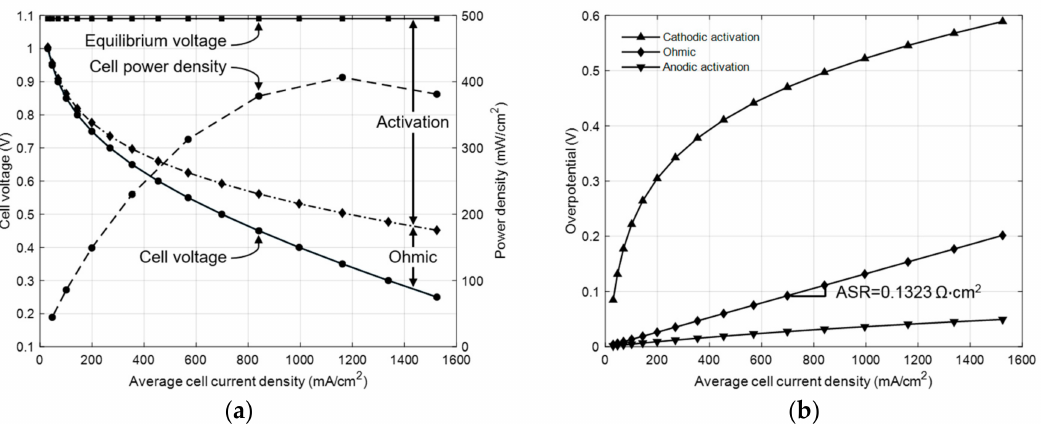
Figure 3. ( a ) Average cell current density-voltage-power curve (I-V-P) curves; and, ( b ) individual overpotentials with respect to average cell current density for the reference case ( T = 400 ◦ C, H el = 100